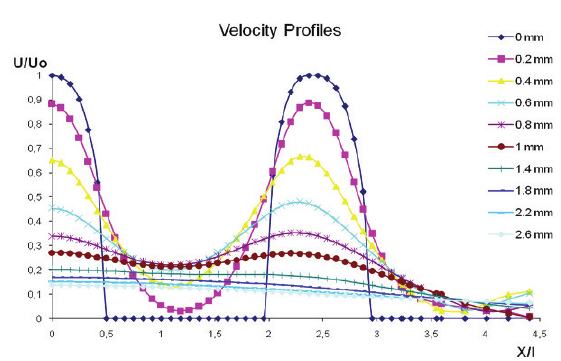
Figure 5. Central jet maximum velocity decay. Comparison between numerical and experimental data: jet-system of in-line ordered 5 circular jets. Influence of the number of the interstices